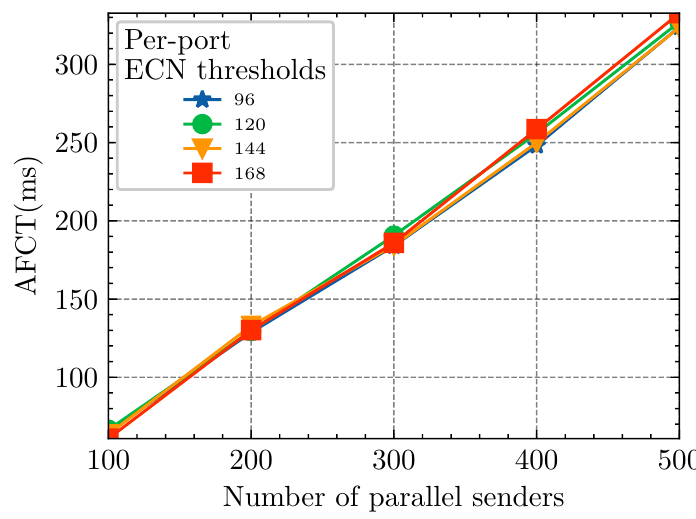
Figure 5. AFCT for short flows with different marking thresholds for per - port ECN